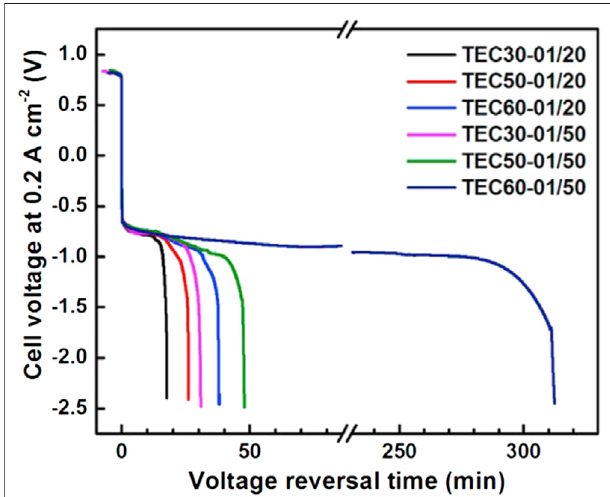
FIGURE 6 | In fl uence of anode CL thickness and IrO 2 loading on the durability of the RTA. Reproduced with permission (Chen et al., 2021b). Copyright 2021,